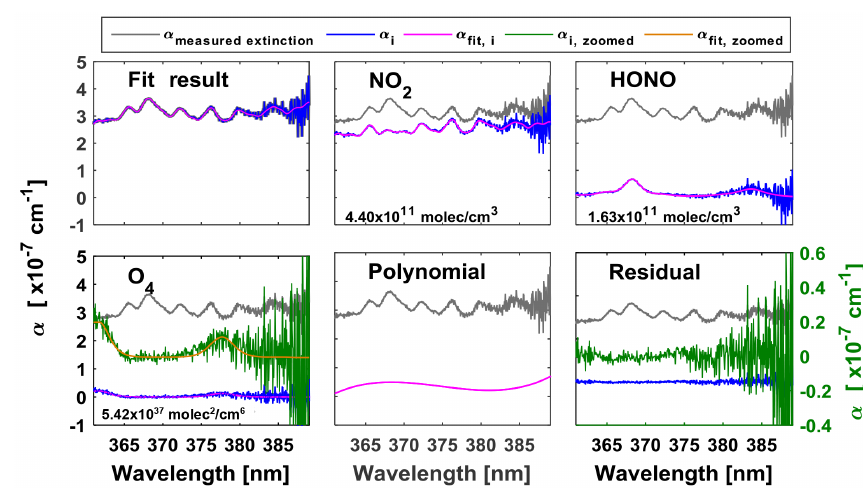
Figure 6. An example of spectral fit for one Ch 368 spectrum (10s average) measured over an agricultural burning plume on the 3 July 2013 nighttime flight during SENEX 2013. Retrievals of NO 2 , HONO, and O 4 are shown, as well as the third-order polynomial, total fit, and residual.